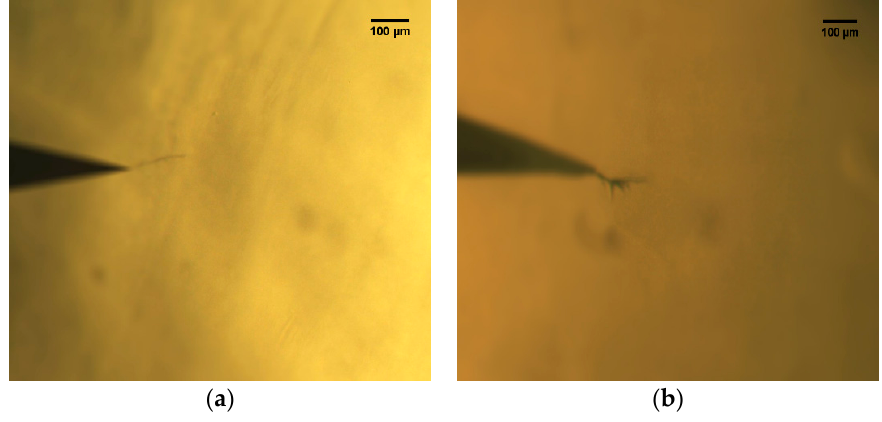
Figure 4. ETs developed at DC voltage ( a ) +28 kV and ( b ) − 28 kV.